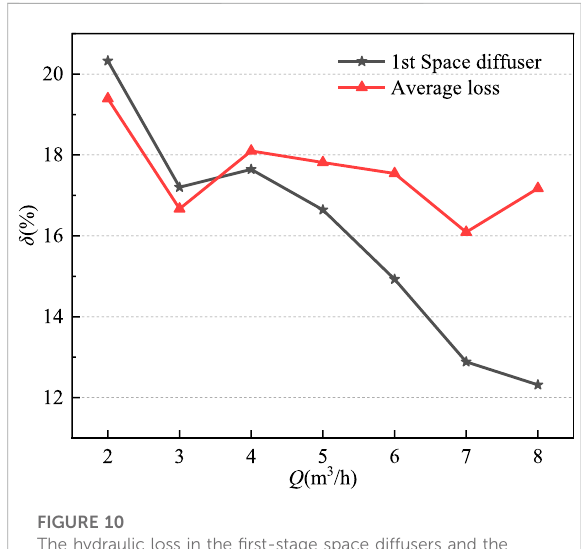
FIGURE 10 The hydraulic loss in the fi rst-stage space diffusers and the average hydraulic loss in the space diffusers at different fl ow